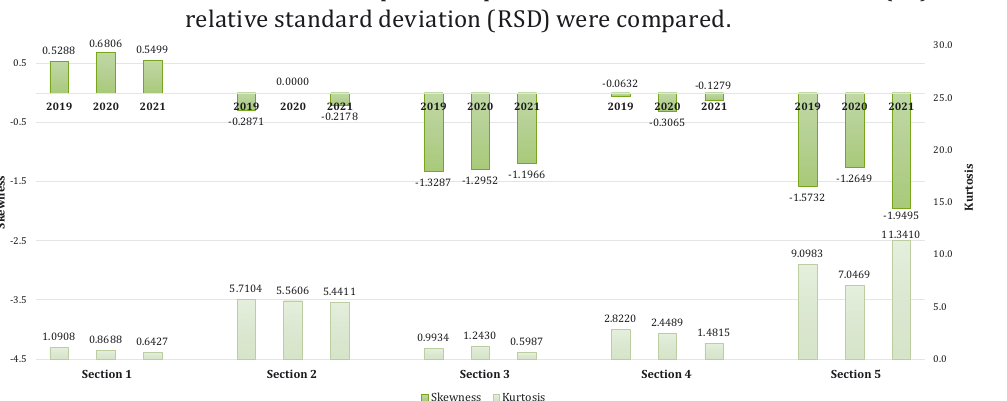
Figure 21. The change of the superelevation values of the selected sections over time, considering the skewness and kurtosis indicators